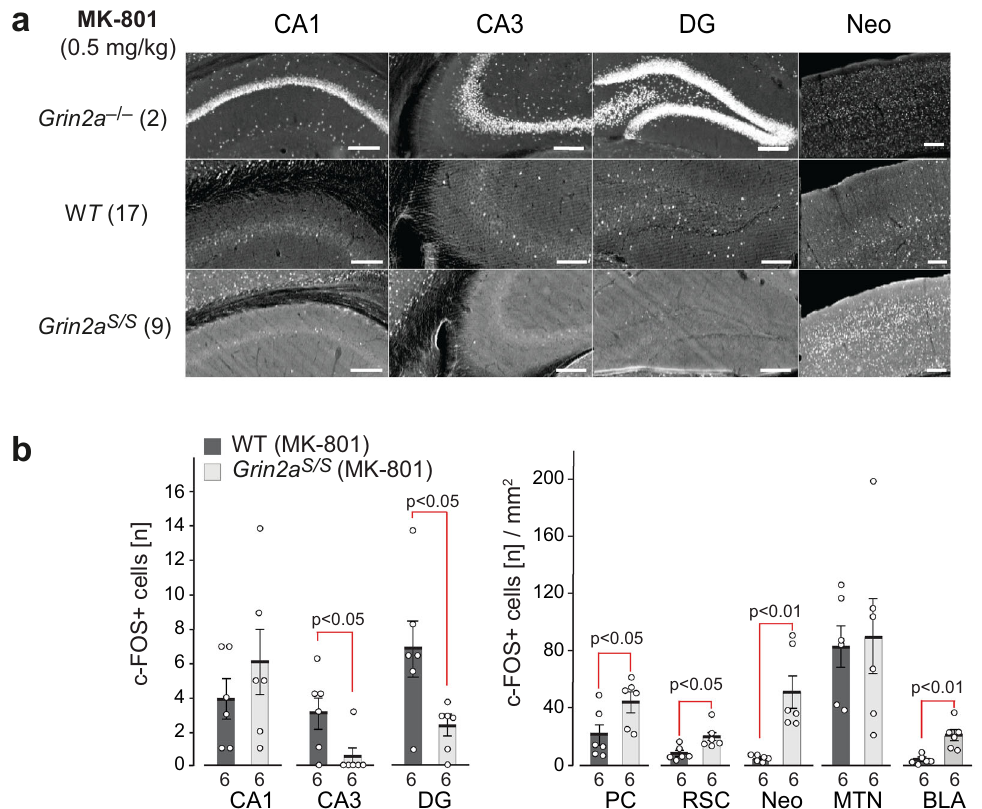
Fig. 5 MK-801-induced c-Fos expression is reduced in DG granular and CA3 pyramidal cells of Grin2a S/S mice. C-Fos expression 120 min after i.p. injection of MK-801. a C-Fos DAB immunosignals are depicted for one representative brain section of the different genotypes as indicated. The original images, including the cortical regions and results of PBS injected animals, are presented in Supplementary Fig. 6. The number of mice analyzed is given in brackets. b For quantitative comparisons the total numbers of c-Fos-positive cells in the cellular layers of the hippocampus were counted. C-Fos-positive cells in extra-hippocampal regions are given per mm 2 . Slices from six mice per genotype were used for the statistical analyses (two-tailed t -tests) and error bars represent mean ± SEM. CA1 and CA3 cornu ammonis regions 1 and 3, DG dentate gyrus, PC piriform cortex, RSC retrosplenial cortex, Neo neocortex, MTN midline thalamic nuclei, BLA basolateral amygdala. All scale bars: 0.2